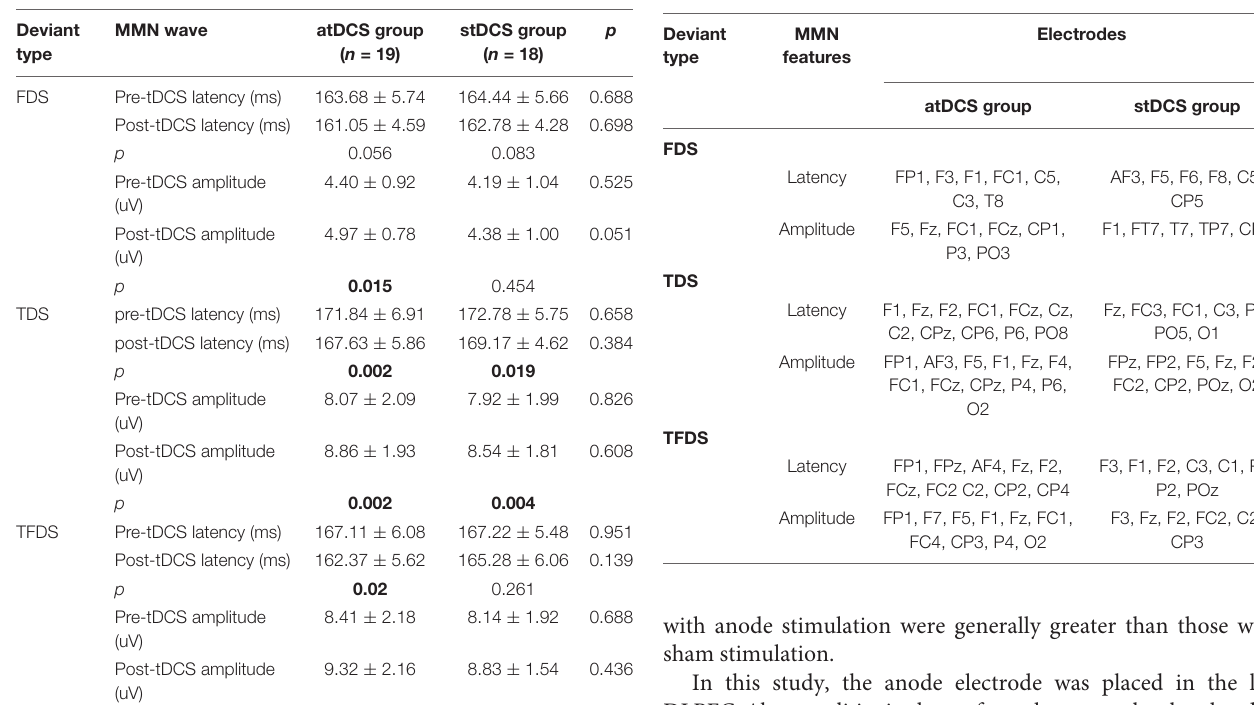
TABLE 5 | List of electrodes with significant differences ( p < 0.05) in the amplitude and latency of the three deviation stimuli between the two